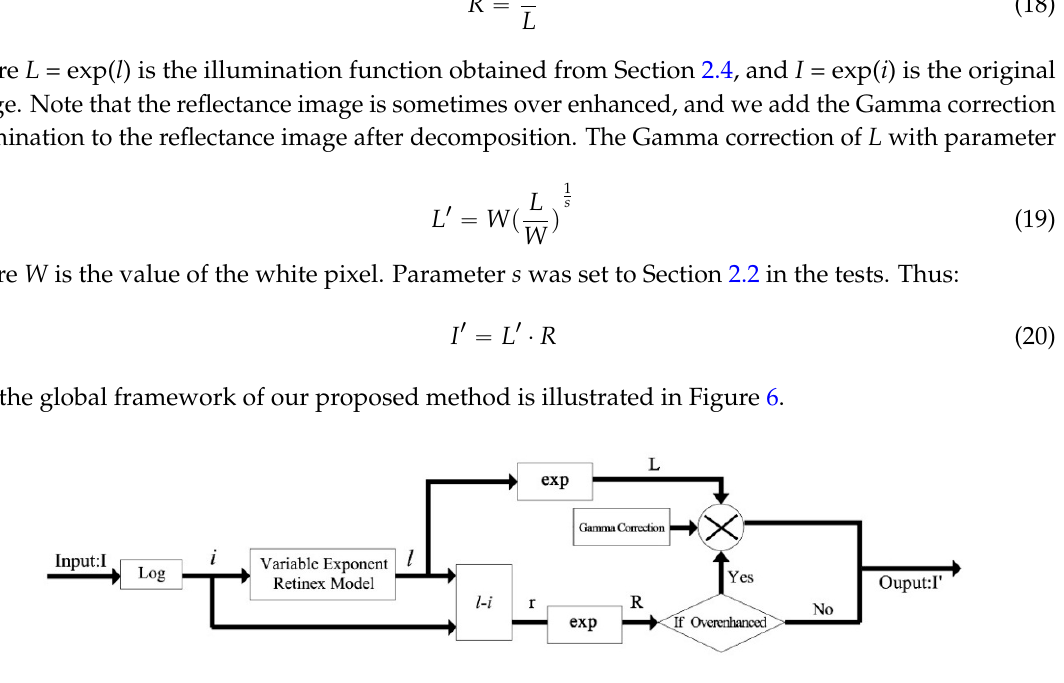
Figure 6. Global framework of the proposed method.